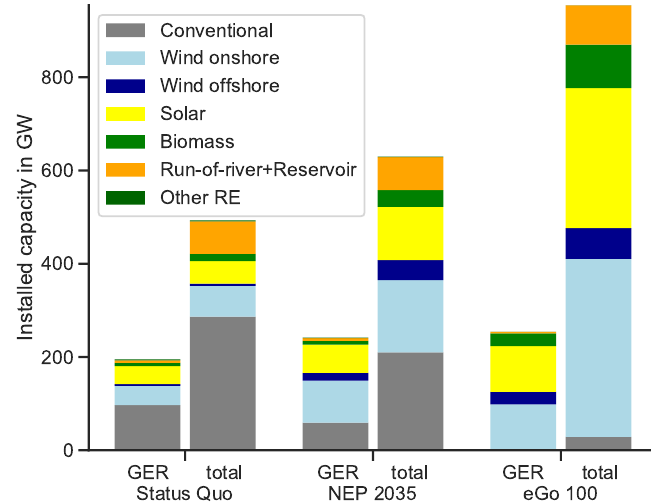
Figure 1. Installed generation capacities for Germany (GER) and the entire model region (total) per scenario and technology/fuel [59].